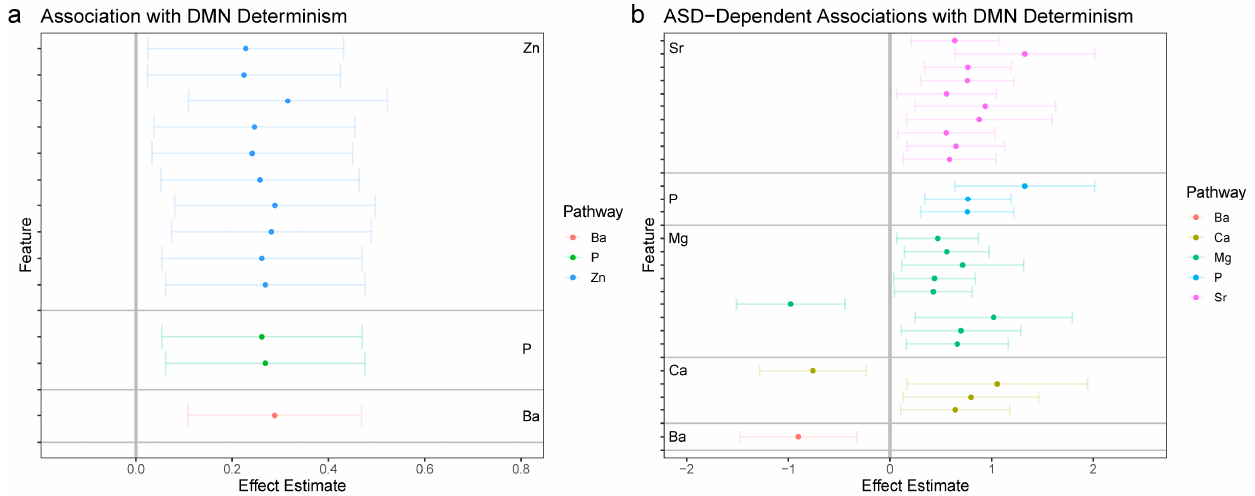
Figure 2. Associations between elemental dynamics and DMN functional connectivity. ( a ) Left panel shows effect estimates for associations between elemental features and determinism in the average DMN signal; only features with significant associations following FDR-adjustment for multiple comparisons are shown. ( b ) Right panel shows effect estimates for the interaction between autism and features of elemental dynamics; features with significant associations following FDR-adjustment for multiple comparisons are shown. The magnitude of effect estimates in essence depicts the difference in a given feature between participants with autism and control participants.